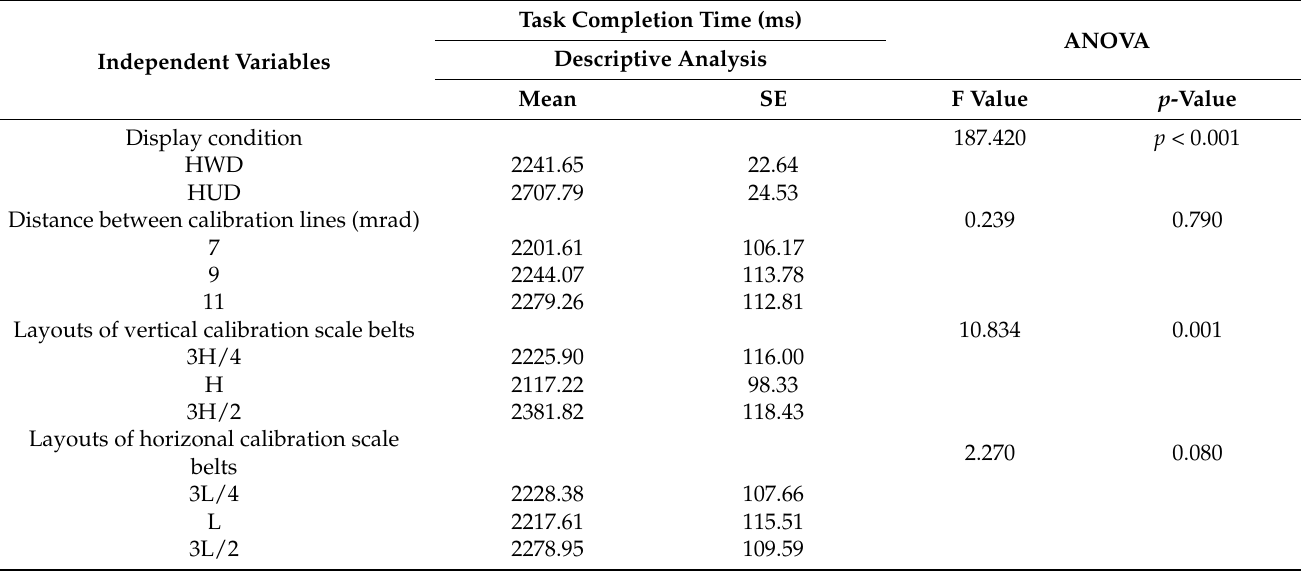
Table 1. Main effects of display condition, distance between calibration lines, and layouts of vertical and horizonal calibration scale belts on task completion time.